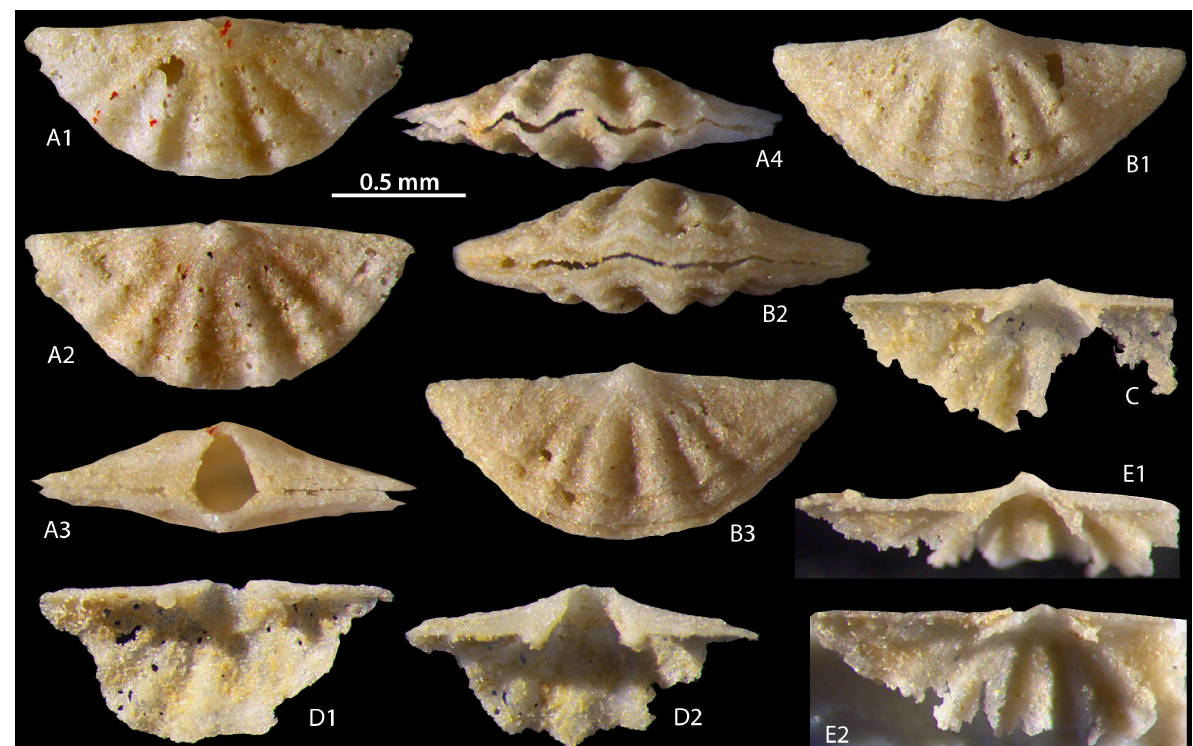
Fig. 5. A(cid:150)E , Tyronella siugensis sp. nov. Porkuni quarry, Porkuni Stage, ˜rina Formation, Siuge Member. A1(cid:150)4, holotype, conjoined valves GIT 626-57, ventral, dorsal, posterior and anterior views. B1(cid:150)3, conjoined valves GIT 626-59, ventral, anterior and dorsal views. C, incomplete dorsal valve GIT 626-62, interior view. D1, 2, ventral valve GIT 626-60, interior and posterior views. E1, 2, dorsal valve GIT 626-58, posterior and interior